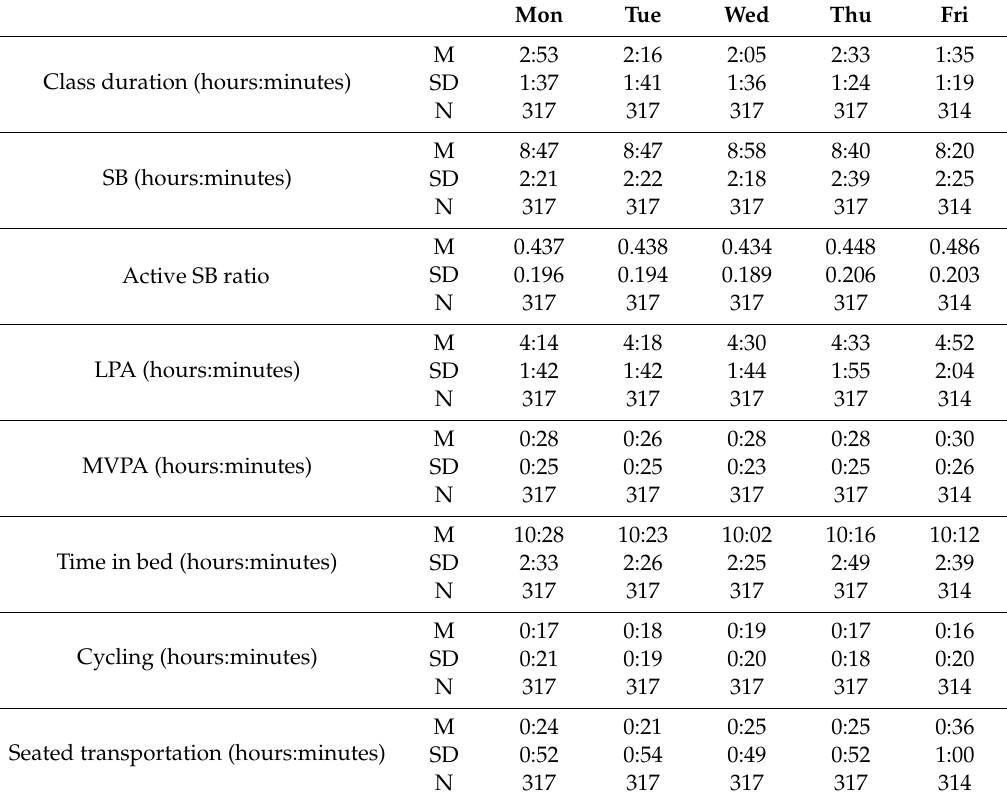
Table2. Students’classduration, physicalactivitybehavior, andtypeoftransportationforeachweekday.